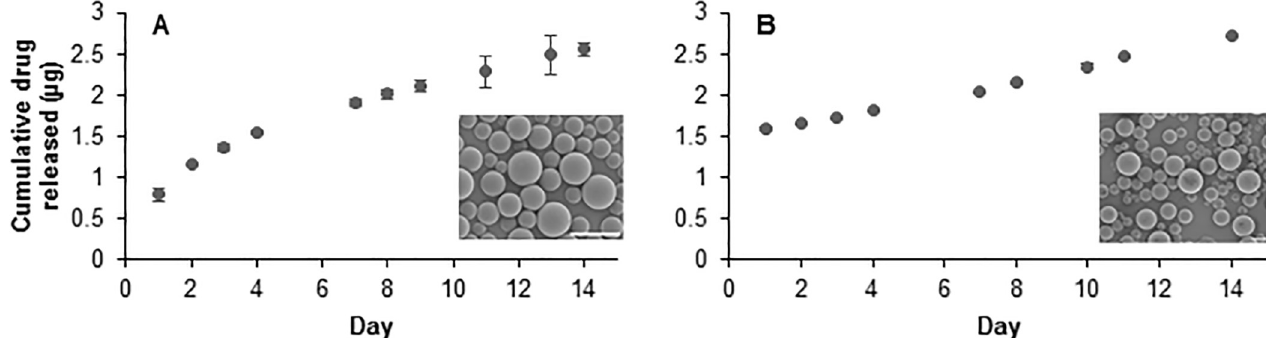
Fig 1. In vitro antibiotic release from microspheres. Cumulative in vitro release of (A) ciprofloxacin and (B) ceftriaxone from 10mg MS over 14 days. Error bars represent the average ± standard error for n = 3 samples. Inset: Scanning electron microscopy images of drug-loaded MS (scale bar = 10 μ m).